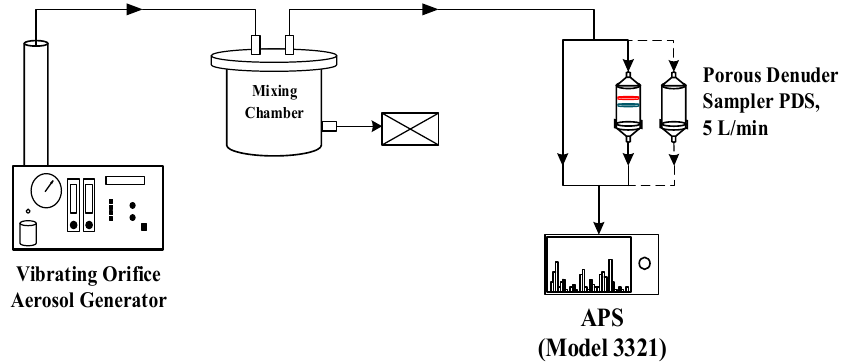
Figure 2. Experimental setup of the penetration curve and particle loss test of the 5 L/min PDS.